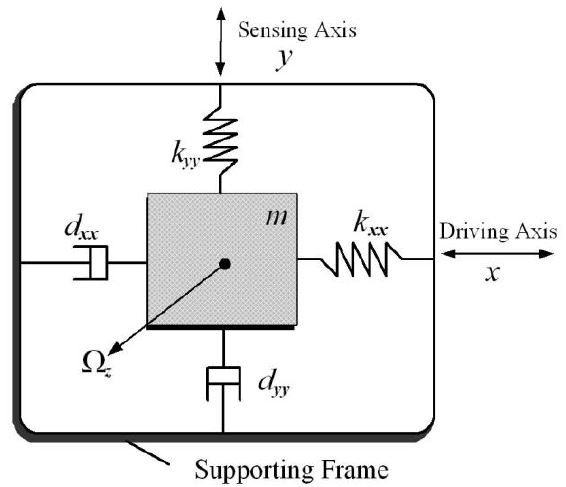
Figure 1. Schematic model of a z -axis MEMS vibratory gyroscope.